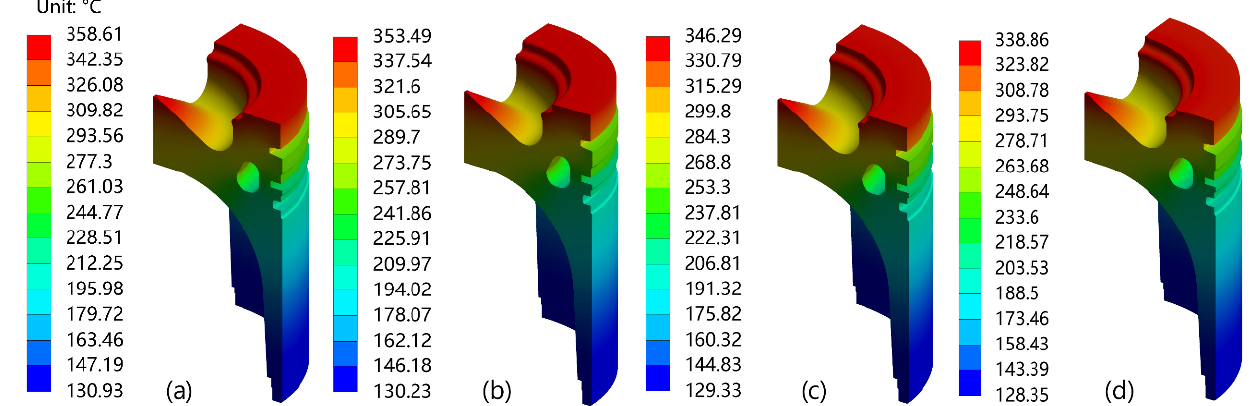
Figure 8. Temperature distribution of substrate surface for various coating thicknesses: ( a ) 0.2 mm, ( b ) 0.3 mm, ( c ) 0.5 mm, ( d ) 0.7 mm.